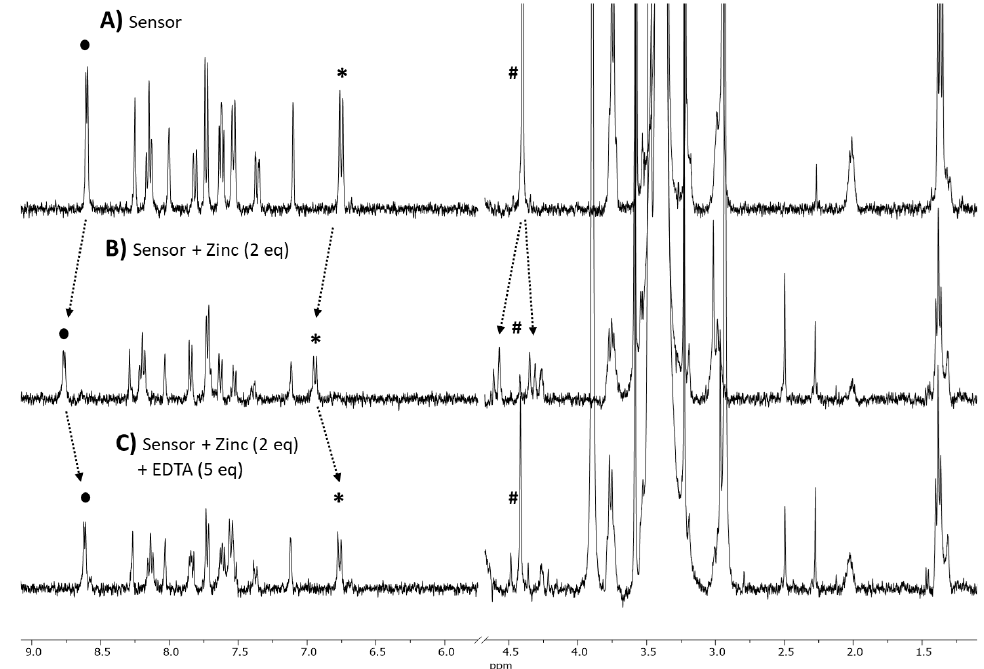
Figure 9. 1 H NMR spectra of [ 1 ]=0.78 mM: ( A ) with no metal; ( B ) in the presence of 2 equiv. of zinc; ( C ) in the presence of 2 eqs. of zinc and 5 eqs. of EDTA. All spectra were conducted at room temperature in a mixture of MeOD:D 2 O (1:1).